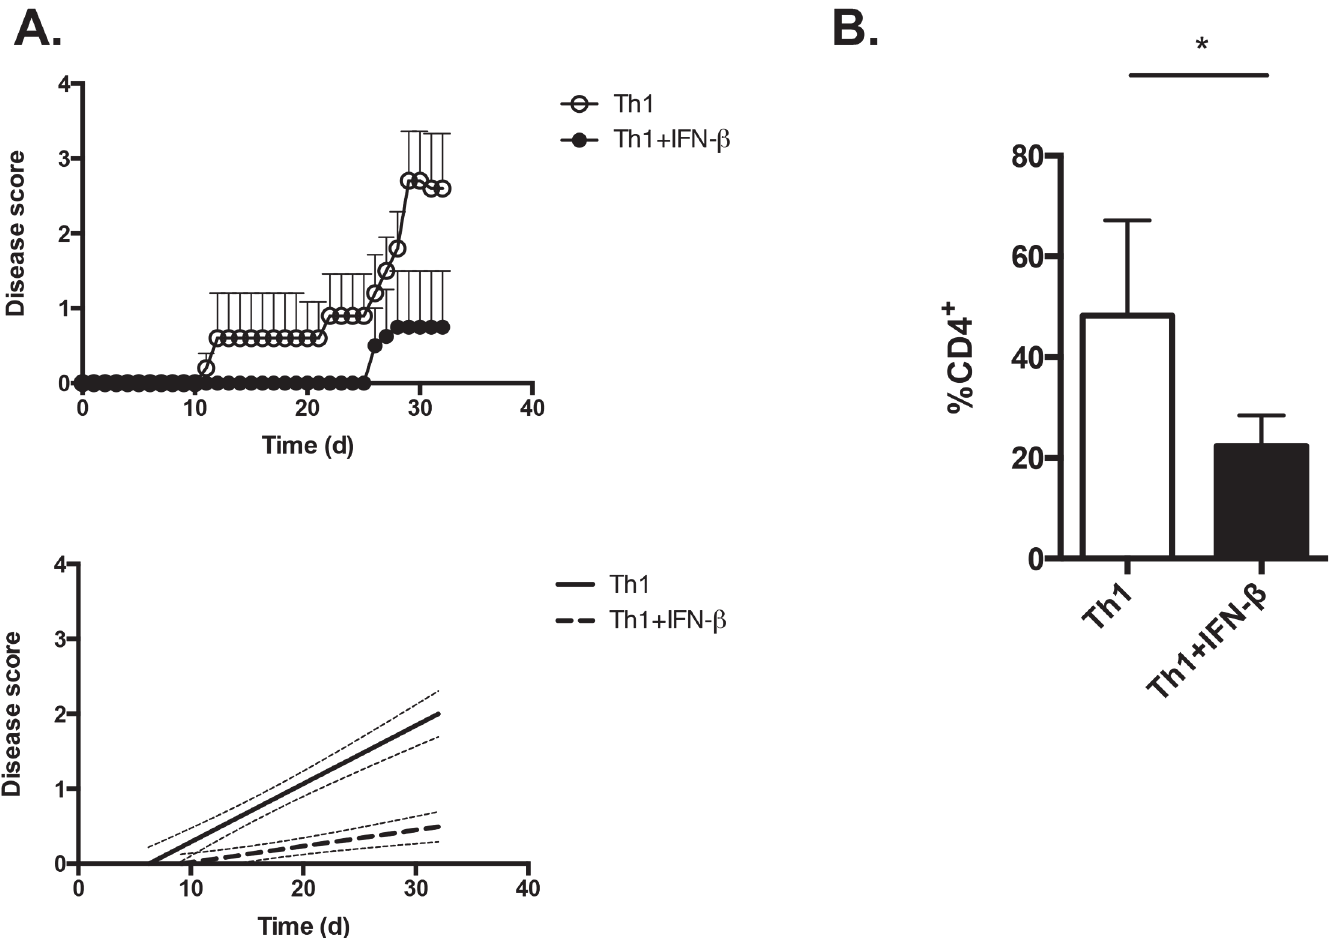
Fig 3. IFN- β suppresses the encephalitogenic potential of Th1 cells. CD4 + CD62L hi T cells were isolated from female 2D2 mouse spleens and lymph nodes, and were stimulated with plate-bound anti-CD3+anti-CD28 under Th1 conditions, in the presence or absence of 100 U mL -1 of IFN- β , for 5 days. They were then transferred to female, 6-week old, Rag1-/- mice (5x10 6 cells/mouse). Recipient mice were monitored for clinical signs of EAE. n = 5 Th1, n = 4 Th1 +IFN- β . Right graph, linear regression curves of the disease courses. The slopes are significantly different between the disease courses (p < 0.0006). B. Brains and spinal cords were isolated from mice in (A) at d32 and single mononuclear cell suspensions were obtained. The frequency of CNS-infiltrating CD4 + cells was assessed by flow cytometry. * p < 0.05, two-tailed Student ’ s t